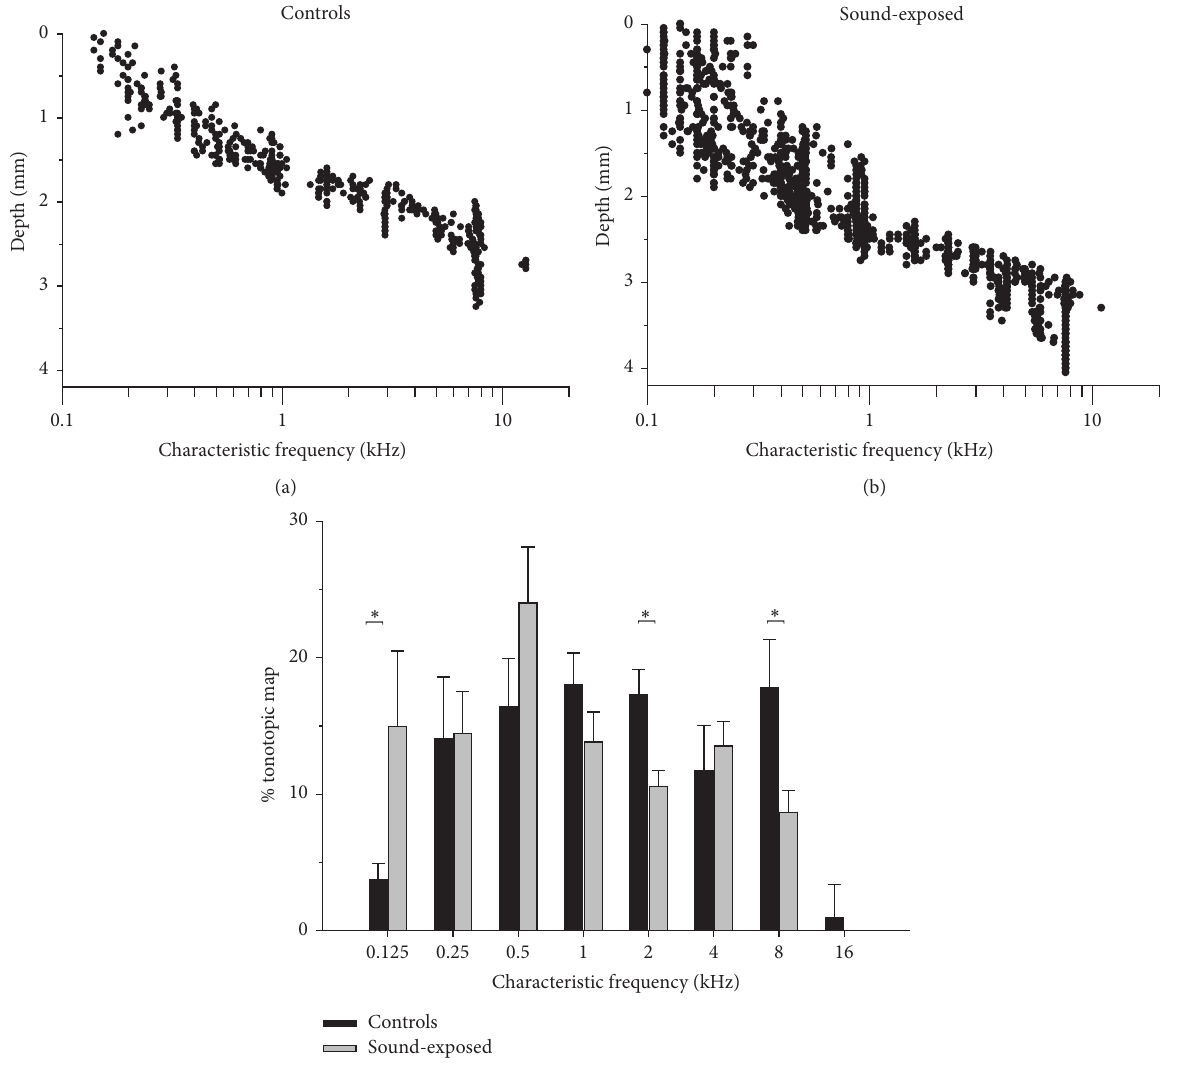
Figure 9: ((a) and (b)) Unit characteristic frequency versus electrode depth in IC. Pooled data from 6 normal control subjects ((a); 𝑛 = 426 , 16 electrodetracks)andfrom52kHzneonatallysound-exposedsubjects((b); 𝑛 = 983 ,20tracks).(c)Comparisonofoctave-spaceddistributions of CF between control and sound-exposed groups ((c); ∗ 𝑝 < 0.05